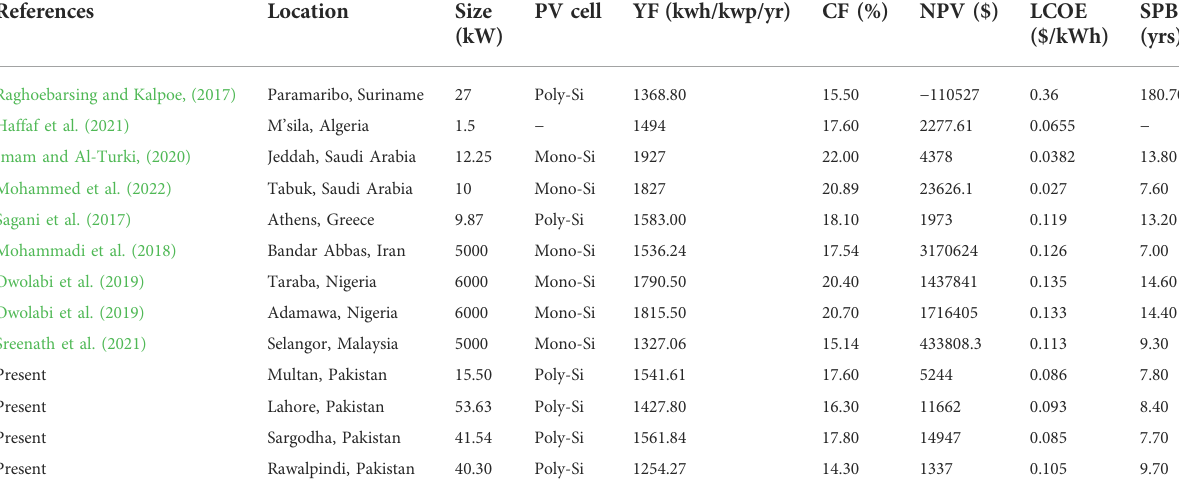
TABLE 11 Performance comparison of grid-connected solar PV plants in different